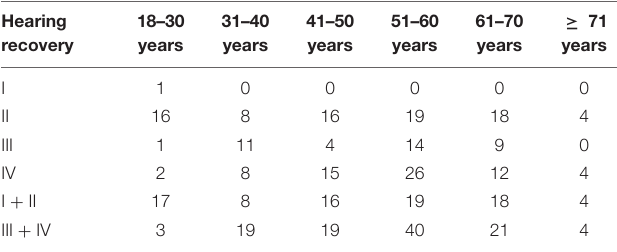
TABLE 3 | Distribution of PTA recovery 1 month posttreatment (six